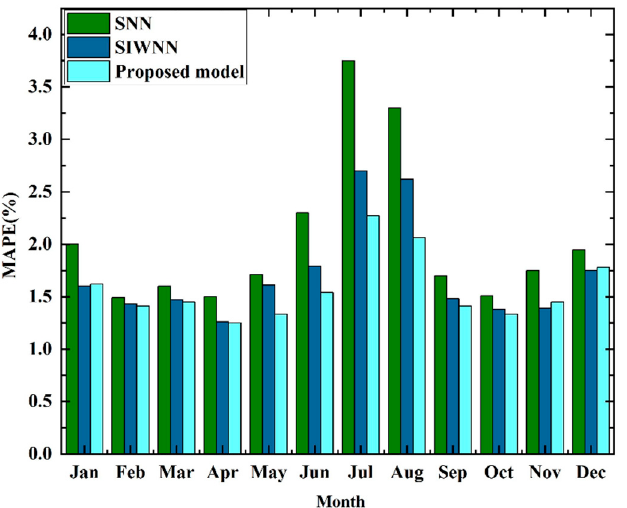
Figure 7. Comparison of monthly MAPE results between the proposed model and other deep learning methods: MAPE, mean absolute percentage error. Table 4. Performance comparison of MAPEs on the data of New England dataset during 2010 and 2011.